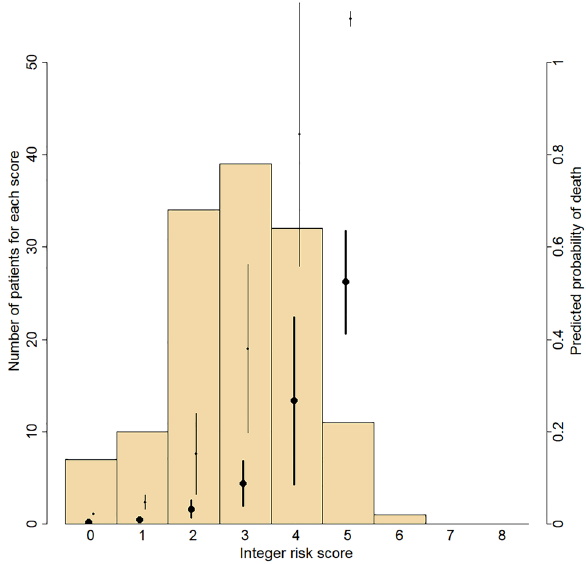
Figure 1. Integer risk score and probability of dying within 1 and 4.4 years in the derivation sample. The histogram shows the number of patients for each score. The points and error bars show the mean predicted probabilities and their Wald’s 95% Confidence Interval. In bold, the predicted probabilities of dying within 1 year; in light, the predicted probabilities of dying within 4.4